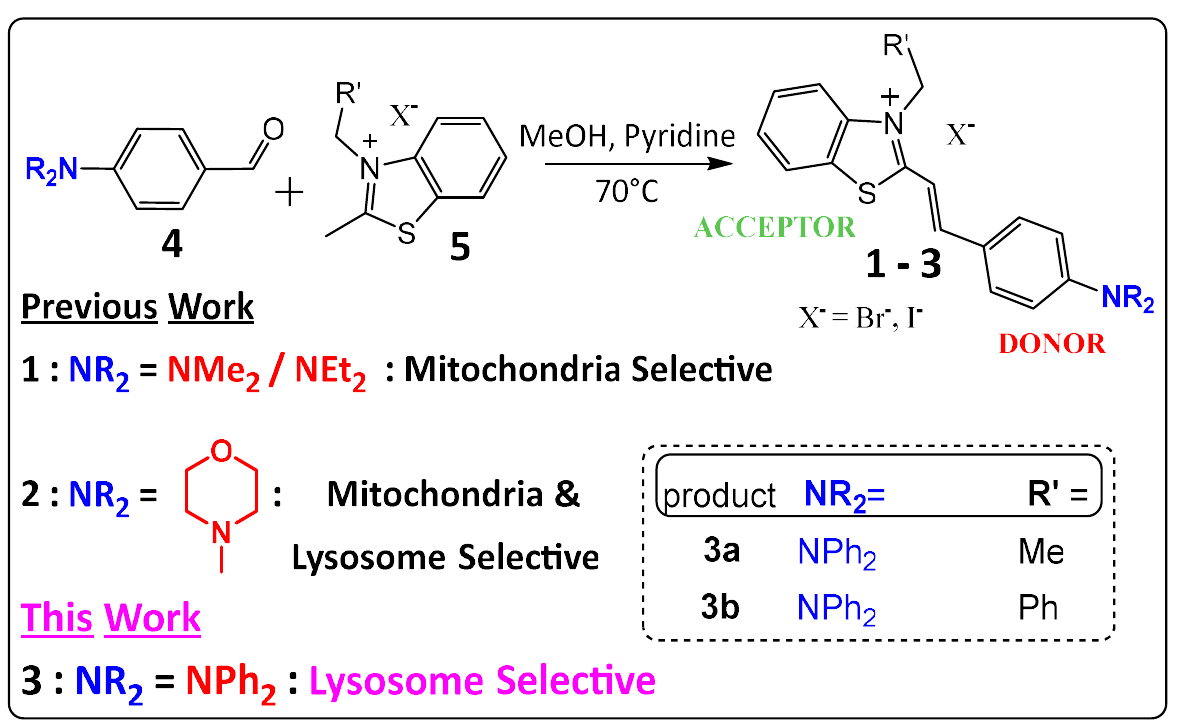
Scheme 1. Schematic representation of the synthesis and the selectivity comparison in donor-π- acceptor probes 1 – 3